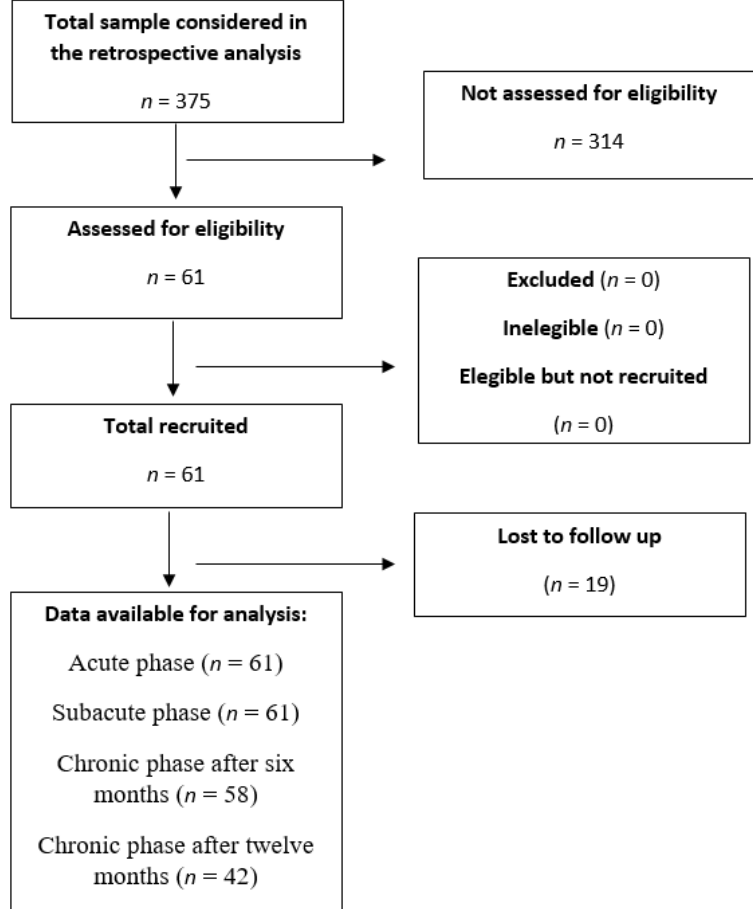
Figure 1. Strobe flow chart.